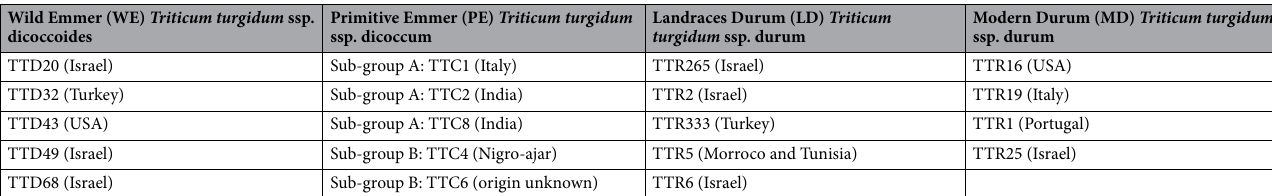
Table 1. Tetraploid wheat lines used in this study